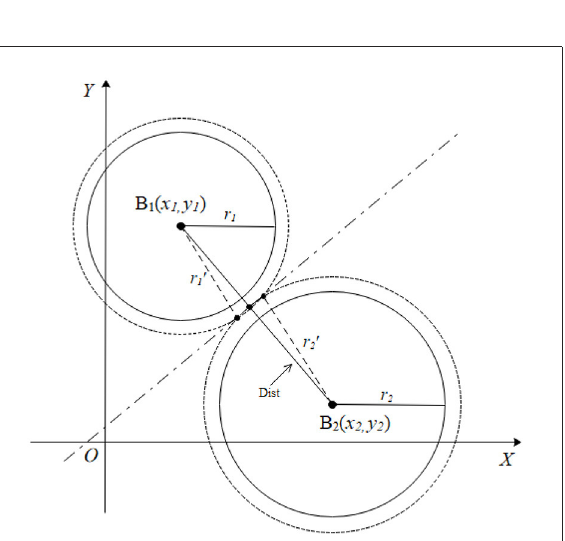
FIGURE4 A representation of the separation of two circles.